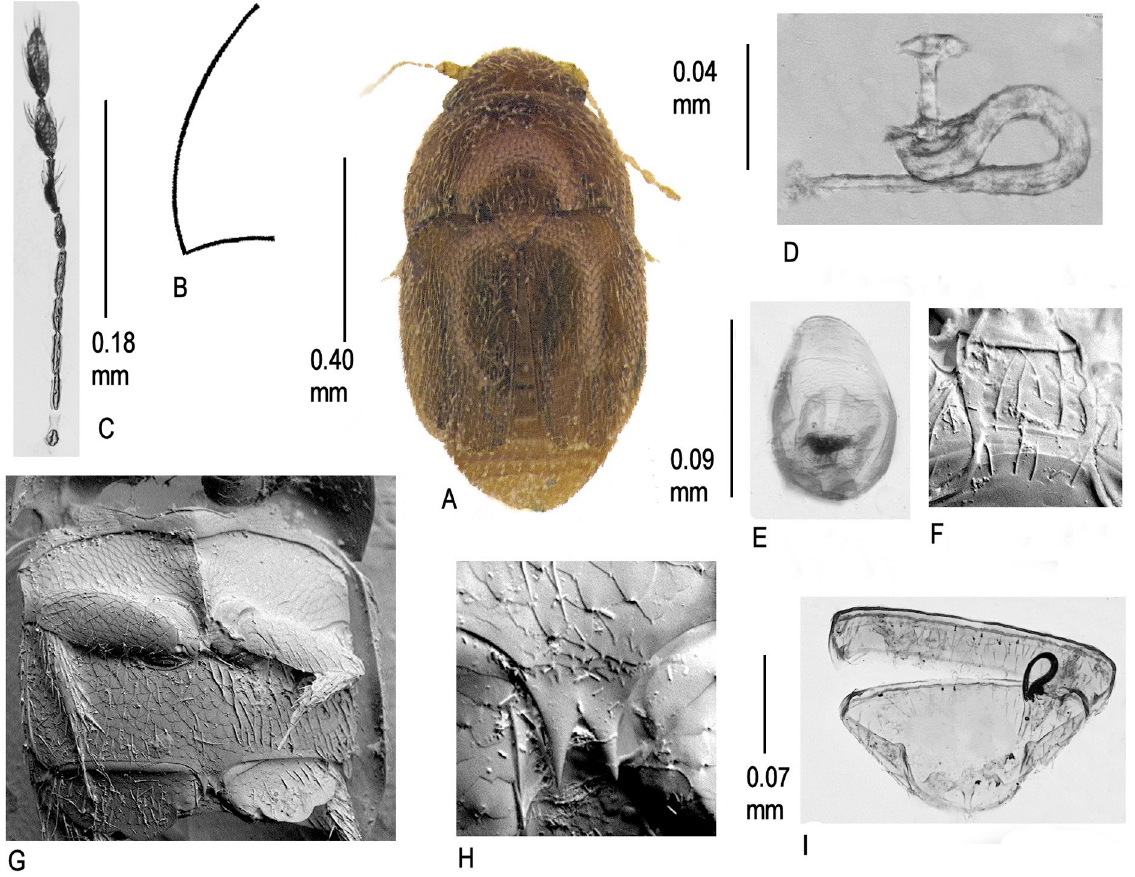
Fig. 23. Storicricha resticula sp. nov. A . Habitus. B . Hind angle of pronotum viewed at 45°. C . Antennomeres III–XI. D . Spermatheca. E . Aedeagus. F . Mentum and submentum ×1000. G . Meso- and metaventra ×320. H . Bifid process between metacoxae ×1700. I .